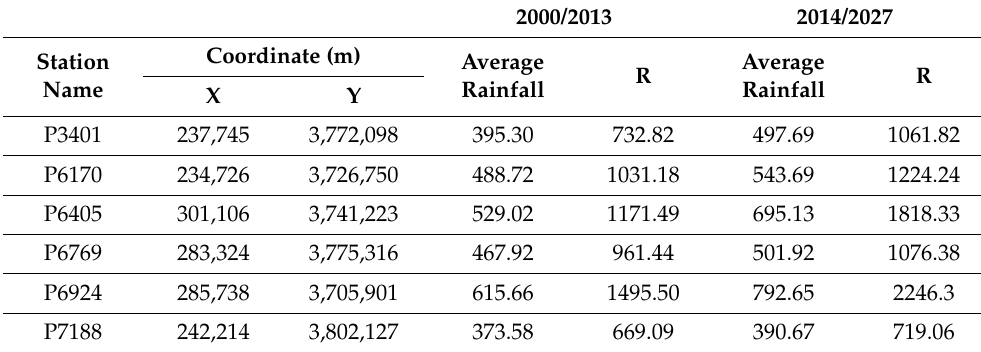
Table 2. Monitoring and prediction annual average rainfall and R Factor of R’Dom